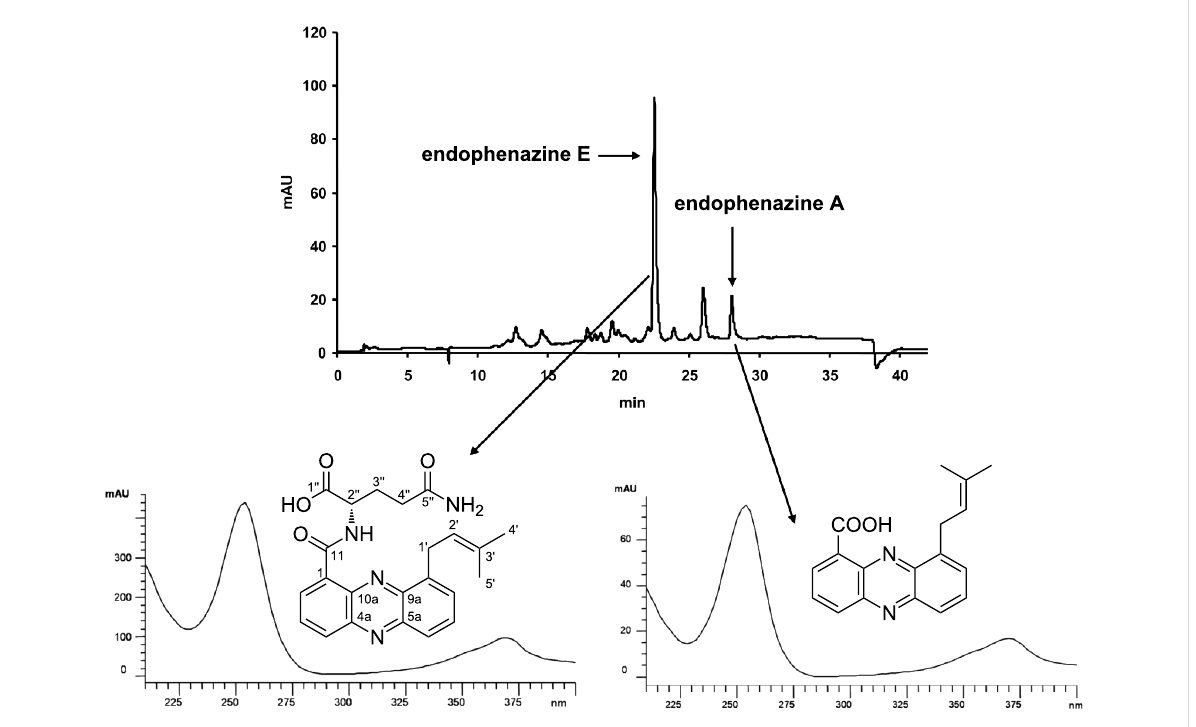
Figure 3: HPLC analysis of mycelia of the heterologous expression strain S. coelicolor M512(ppzOS04) after five days of cultivation. The oxygen carrier Q2-5247 was not included in the culture medium in this experiment. Detection wavelength: 365 nm. The lower panels show the UV spectra of endophenazine A and endophenazine